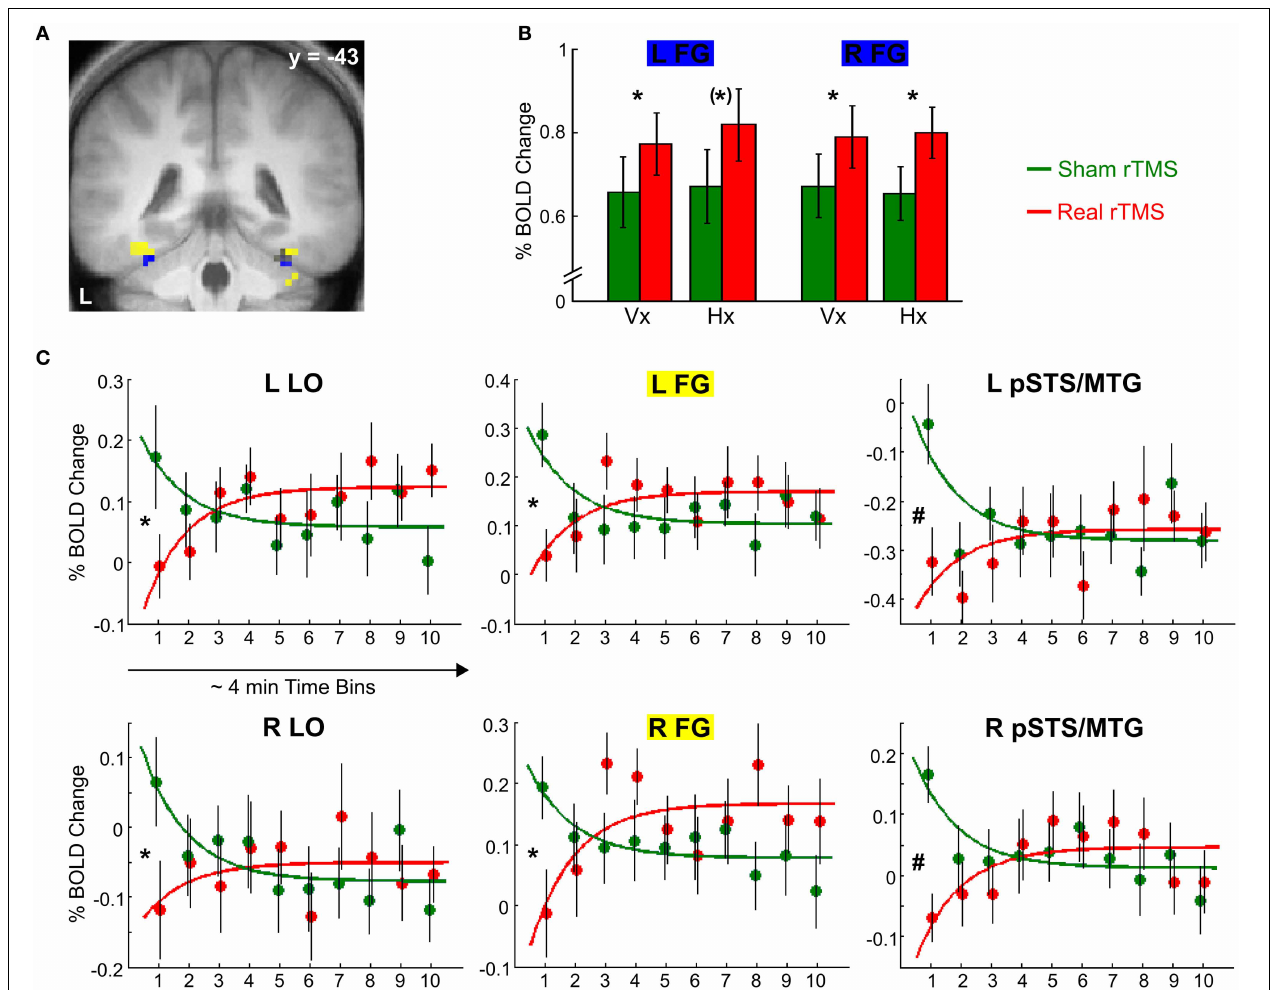
FIGURE 4 | Effects of real rTMS on S1 processing. (A) Activation map showing temporally stable increases in activation (blue) and transient decreases in activation (yellow) in bilateral FG after real compared to sham rTMS ( p < 0 . 01, uncorrected). (B) Temporarily stable increases in activation in bilateral FG (blue portion in (A) , MNI coordinates x , y , z ; left: − 33, − 46, − 23; right: 33, − 43, − 23) to both visual S1 (Vx) and haptic S1 (Hx) after real (red) relative to sham rTMS (green). (C) Transient rTMS-induced decreases in activation during haptic S1 encoding. Regional activity in bilateral LO, FG, and pSTS/MTG showed an interaction of exponential time-dependent effects by rTMS condition when haptic S1 were processed: Whereas